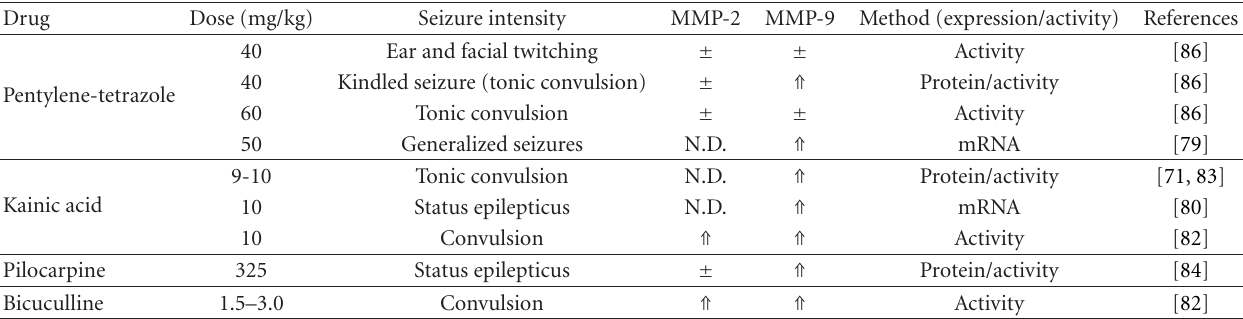
Table 6: Summary of changes in brain MMP expression levels and activities induced by chemical stimulants.